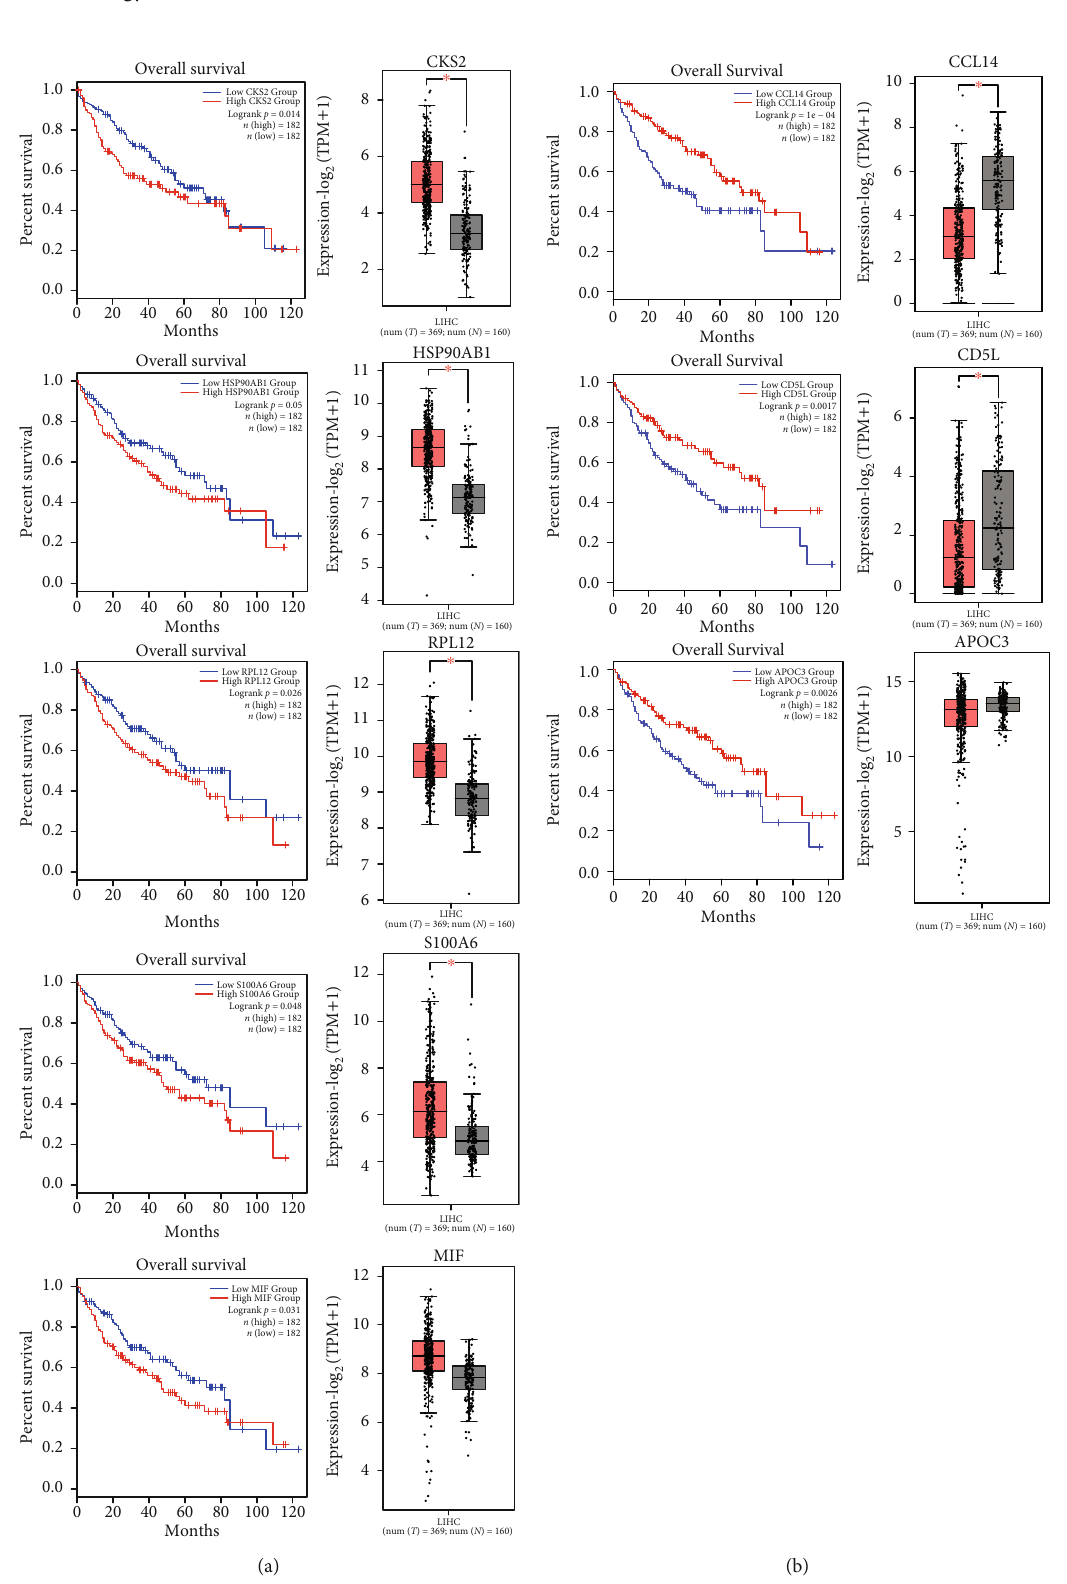
Figure 5: Impact of the DEGs between fi brosis and HCC in the HCC patients. (a, b) Kaplan-Meier analysis of overall survival according to the gene expression in HCC patients from the TCGA dataset. The p value was calculated by the log-rank test. (a) The high expression of CKS2, HSP90AB1, RPL12, S100A6, and MIF predicts poor prognosis. Analysis of mRNA expression in HCC compared to normal liver tissue. ∗ p < 0 : 05 . (b) The low expression of CCL14, CD5L, and APOC3 predicts poor prognosis. Analysis of mRNA expression in HCC compared to normal liver tissue. ∗ p < 0 : 05